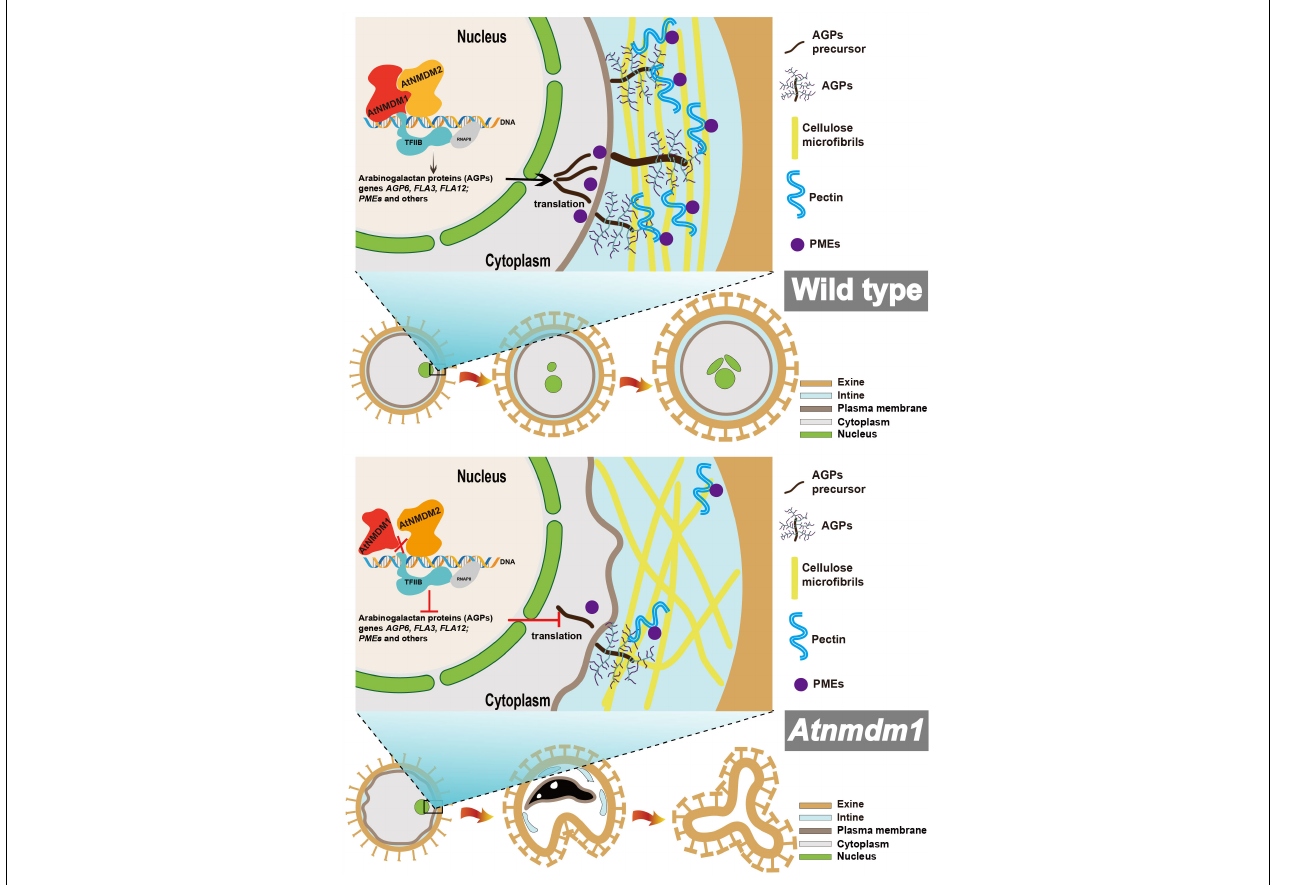
FIGURE 9 | Model of the proposed role for AtNMDM1 regulating AGP and PME genes and thus affecting intine development. AtNMDM1 forms an RNAP II transcription complex together with AtNMDM2 and transcription factor II B (TFIIB), regulating the expression of AGPs and PMEs. AGPs and PMEs function together in the development of the pollen wall, leading to a normal distribution of cellulose, then resulting in the abnormal development of the pollen intine layer. The dashed line represents the potential pathway. ROS, reactive oxygen species; RNAP II, RNA polymerase II; AGPs, arabinogalactan proteins; PMEs, pectin methylesterase; PCD, programmed cell